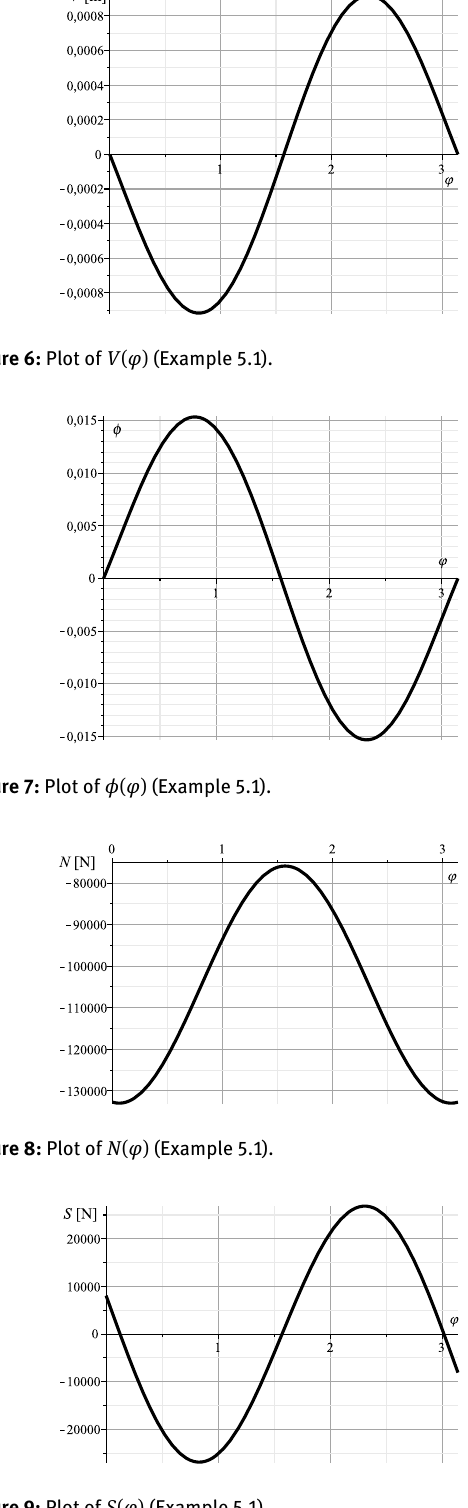
Figure 9: Plot of S ( φ ) (Example